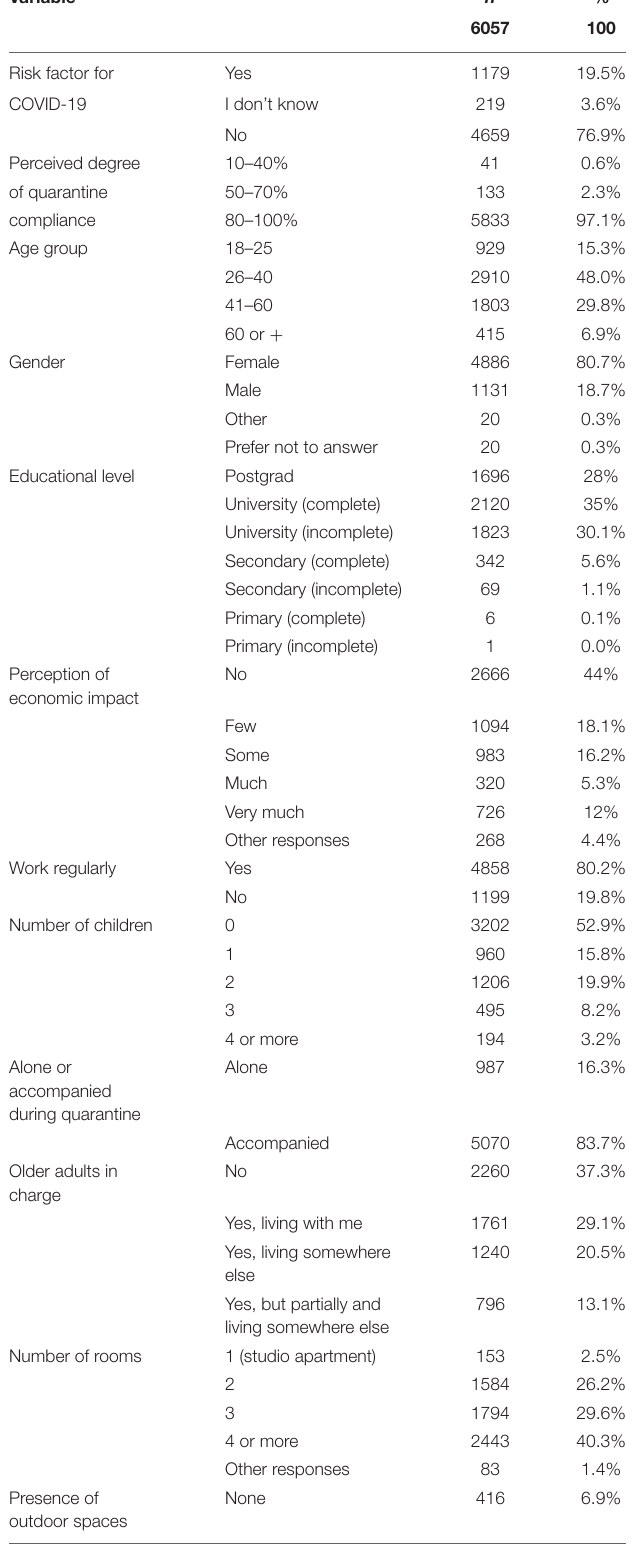
TABLE 1 | Socio-demographic characteristics for all